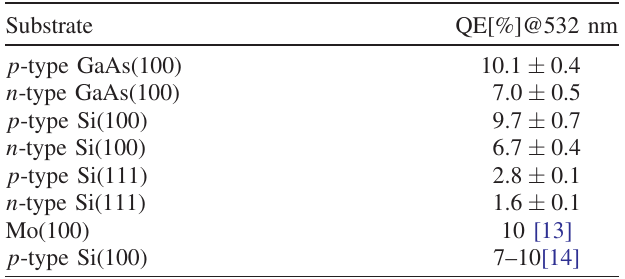
TABLE I. The maximum QE of the CsK 2 Sb photocathode on